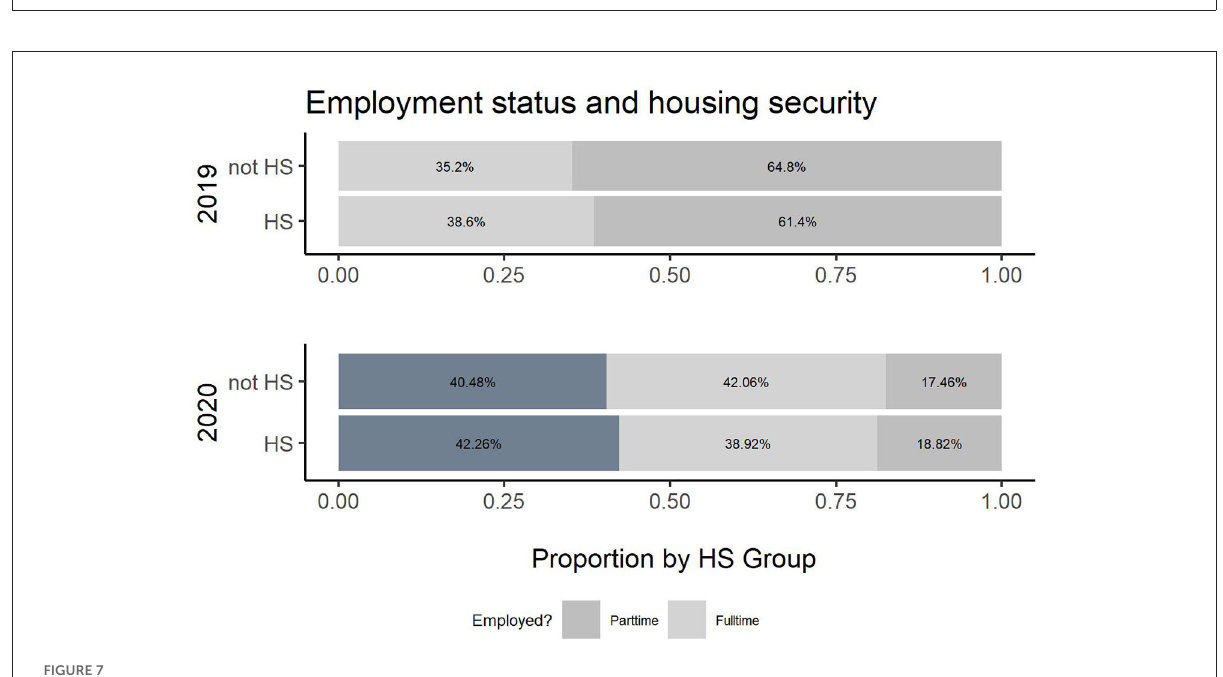
FIGURE7 Employment status and housing